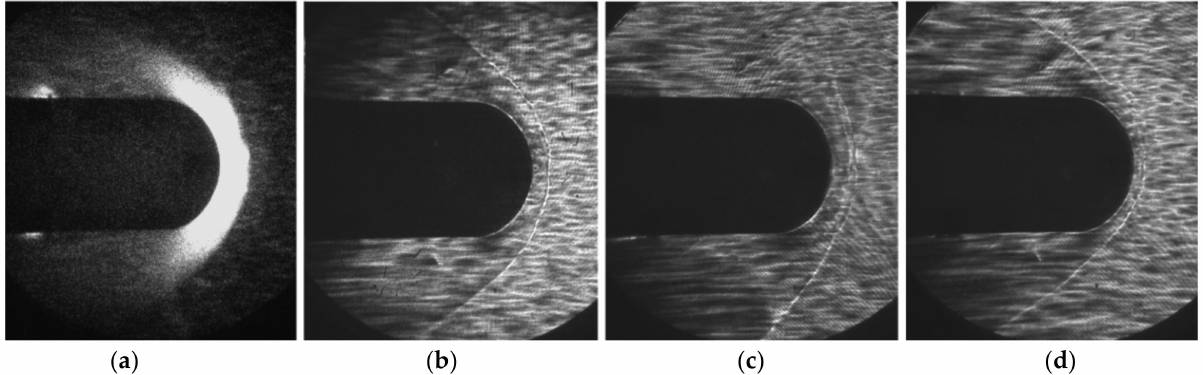
Figure 17. Pictures of the supersonic flow around a body at current I = 800 A connected on a two- electrode circuit: ( a ) Glow of a gas discharge; ( b ) Without magnetic field; ( c ) MHD action at current from the top electrode to the bottom one and B = 1.3 T; ( d ) MHD action at current from the lower electrode to the upper one and B = 1.3